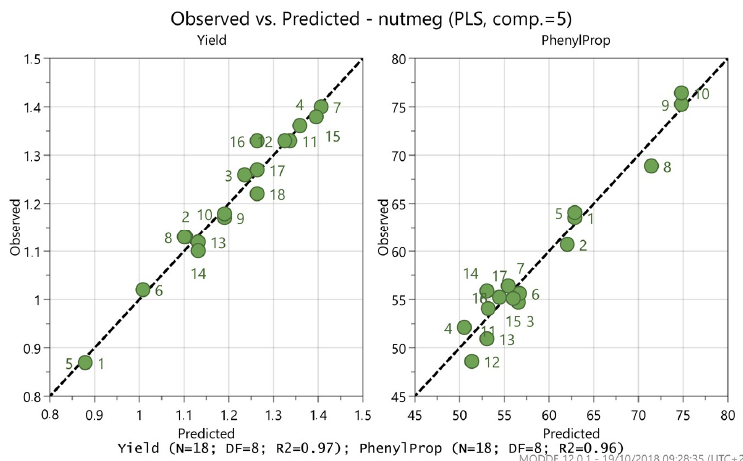
Figure 2. Summary of fit for the model of extraction yield and phenylpropanoids percentage. PLS: partial least squares fitting.